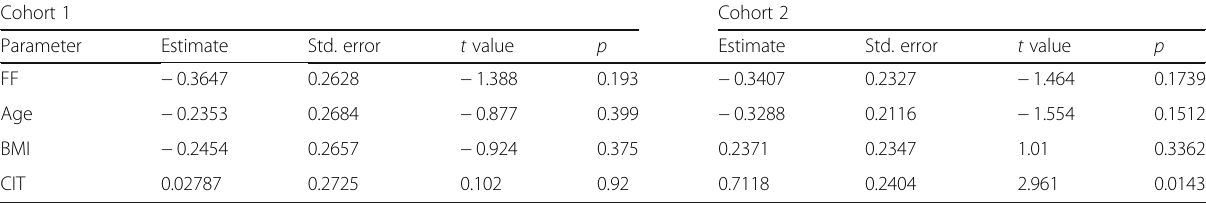
Table 2 Contributions of selected parameters to the multiple linear regression models Cohort 1 Cohort 2 Parameter Estimate Std. error t value p Std. error